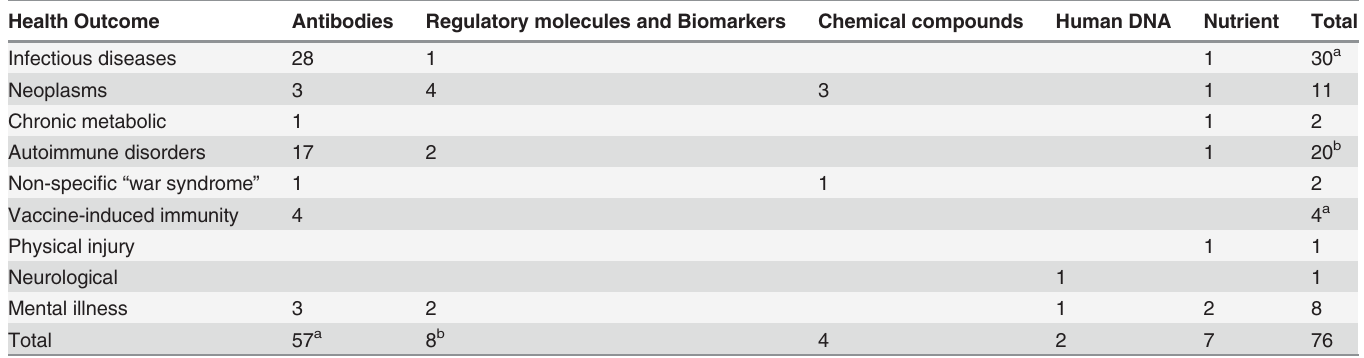
Table 4. Number of publications strati fi ed by types of health outcomes studied using specimens from the DoD Serum Repository and the analytes investigated in those